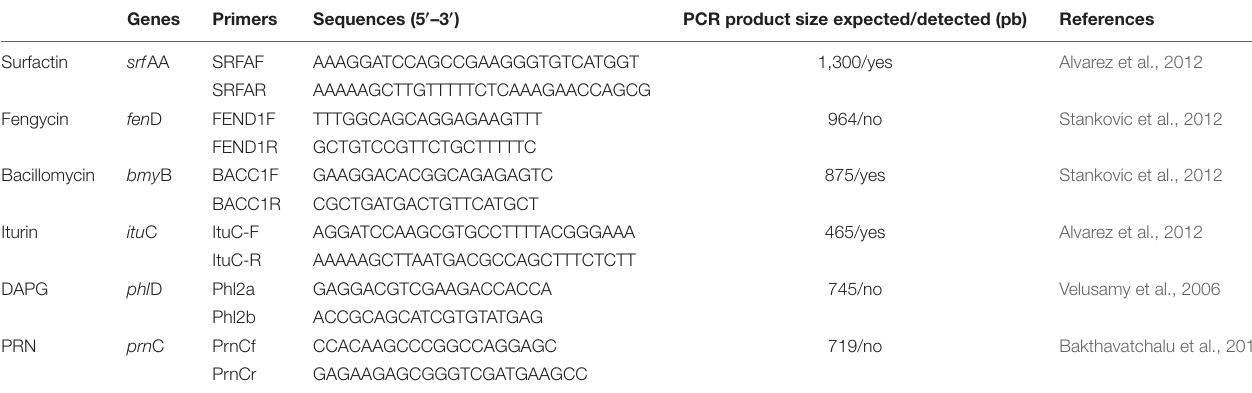
TABLE 1 | Primers used for B. siamensis YC-9 antibiotic encoding genes amplification. Genes Primers Sequences (5 (cid:48) –3 (cid:48)